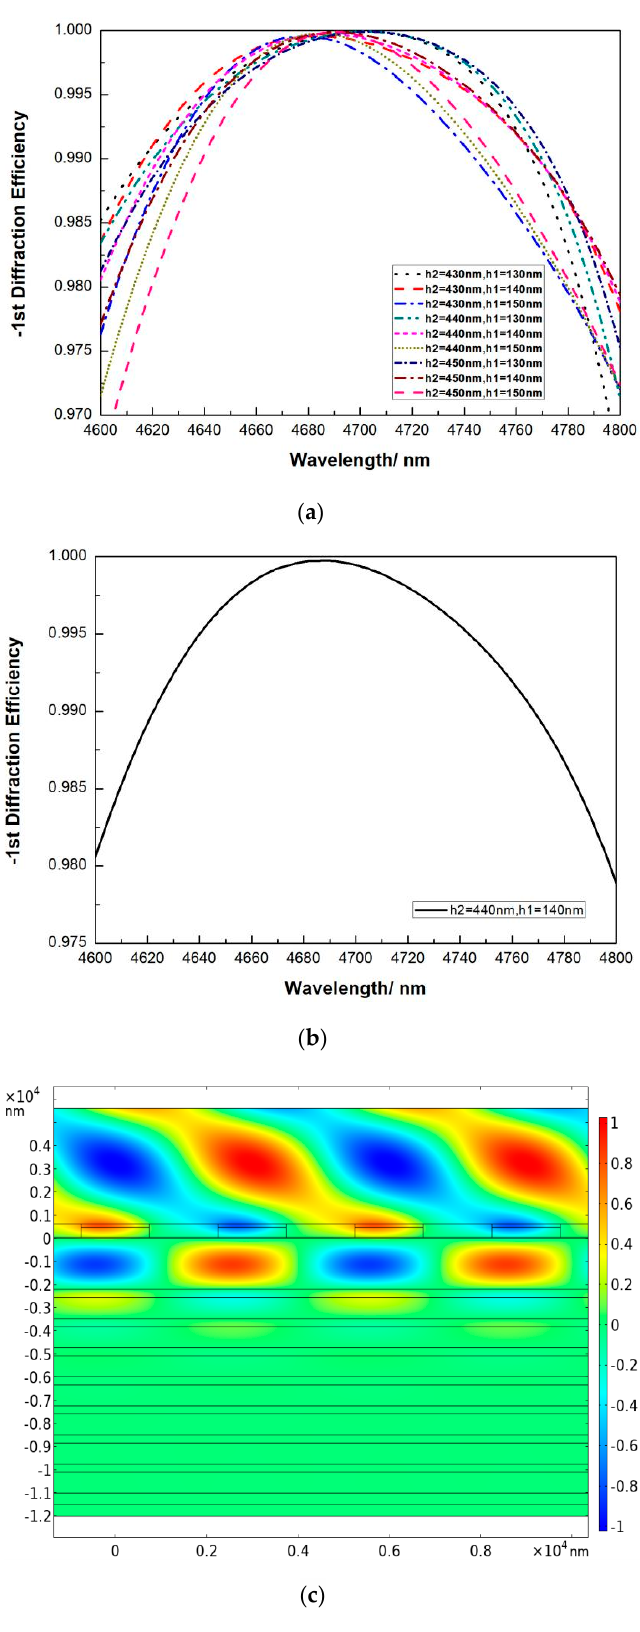
Figure 6. Relationship between the DE versus wavelength, at ( a ) h 1 = 140 nm ± 10 nm and h 2 = 440 nm ± 10 nm and ( b ) h 1 = 140 nm and h 2 = 440 nm. ( c ) Electric field distribution profile for four periods of the incident wavelength at 4.7 μ m, 51.57° incident angle, at h 1 = 140 nm and h 2 = 440 nm.